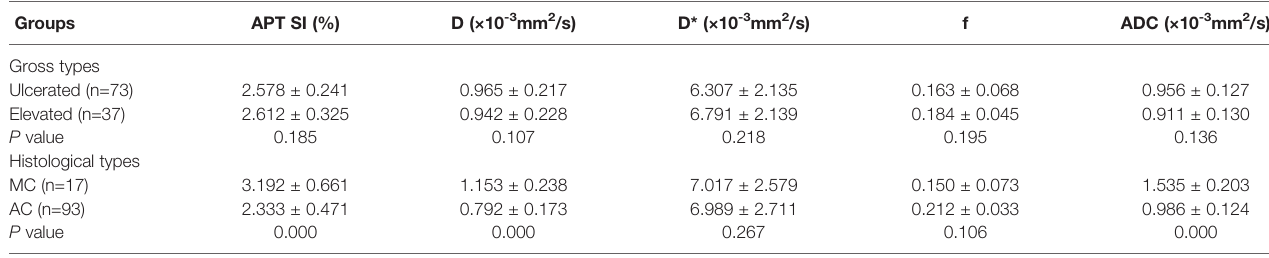
TABLE 3 | The comparison of APT SI, D, D*, f and ADC values in different groups of types. Groups